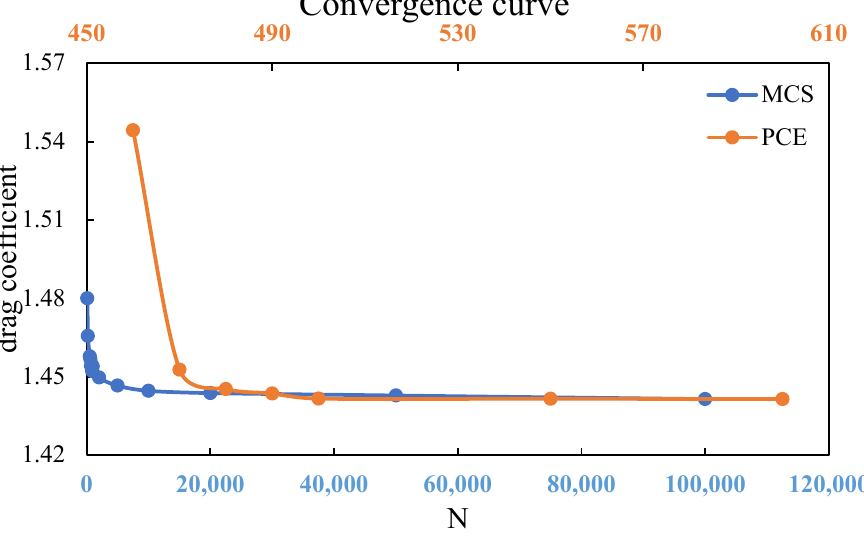
Figure 15. Relationship between sampling points and Cd mean. Table 6. Deterministic optimization and uncertainty-based optimization results of